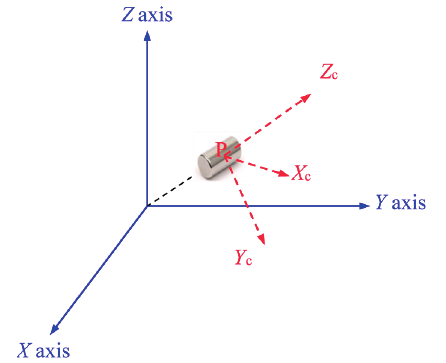
Figure 1. Position and orientation of the magnet in cartesian coordinate